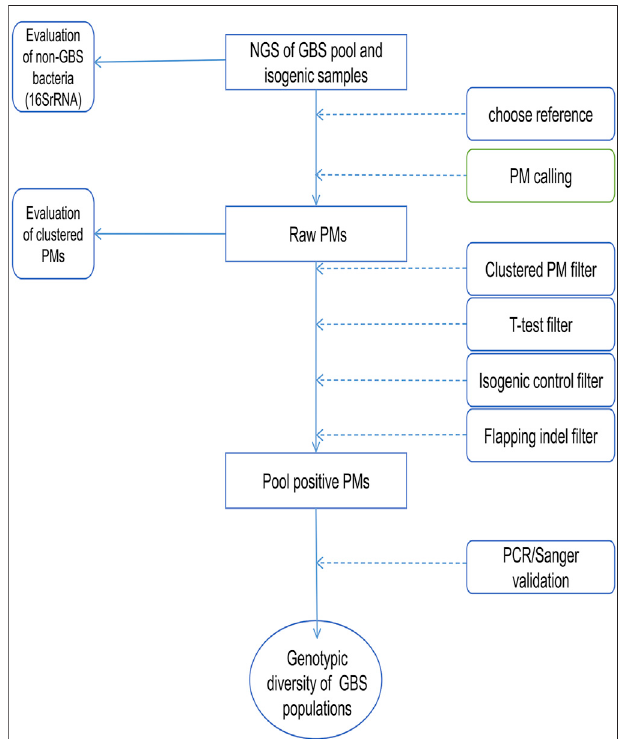
FIGURE 1 | The work fl ow chart of PMcalling. The next-generation sequencing (NGS) reads of the pooled samples and the isogenic control samples were mapped to the appropriate reference genomes, and the raw PMs were called from the two BAM fi les by PMcalling. A series of fi lters were used to remove the false positive PMs introduced by systematic bias, contamination,misalignment,andduplicateregions.ThenVCF fi lesofpositive PMs and indels, as well as nucleotide sequences of the regions where PMs are located were generated from pooled samples and the isogenic control samples, respectively. PMs validated by PCR/Sanger can be further used for genotypic diversity analysis of